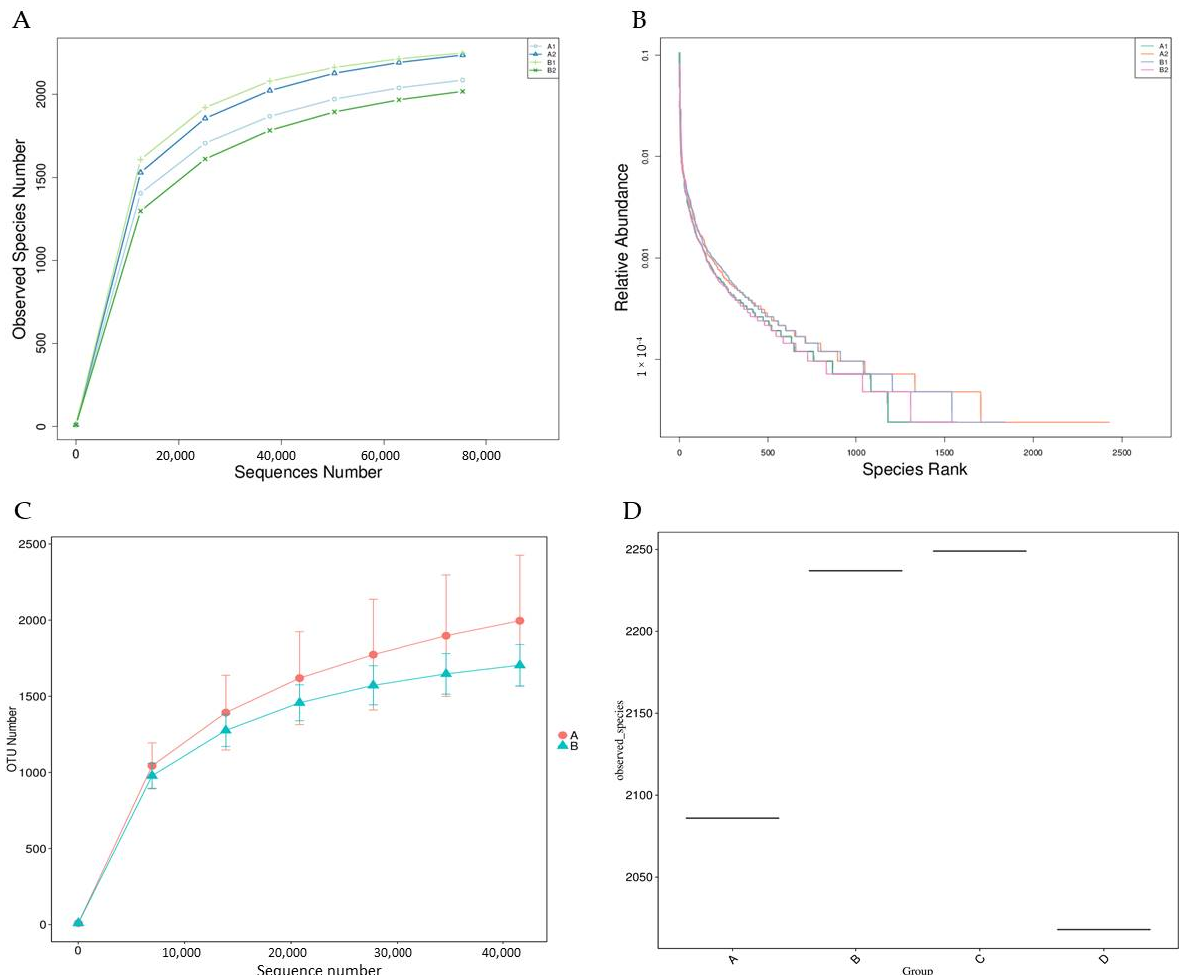
Figure 6. Biodiversity curves. ( A ) Rarefaction curves, indicating the biodiversity of the samples according to the results from alpha-diversity. ( B ) Rank abundance curves. ( C ) Biodiversity by